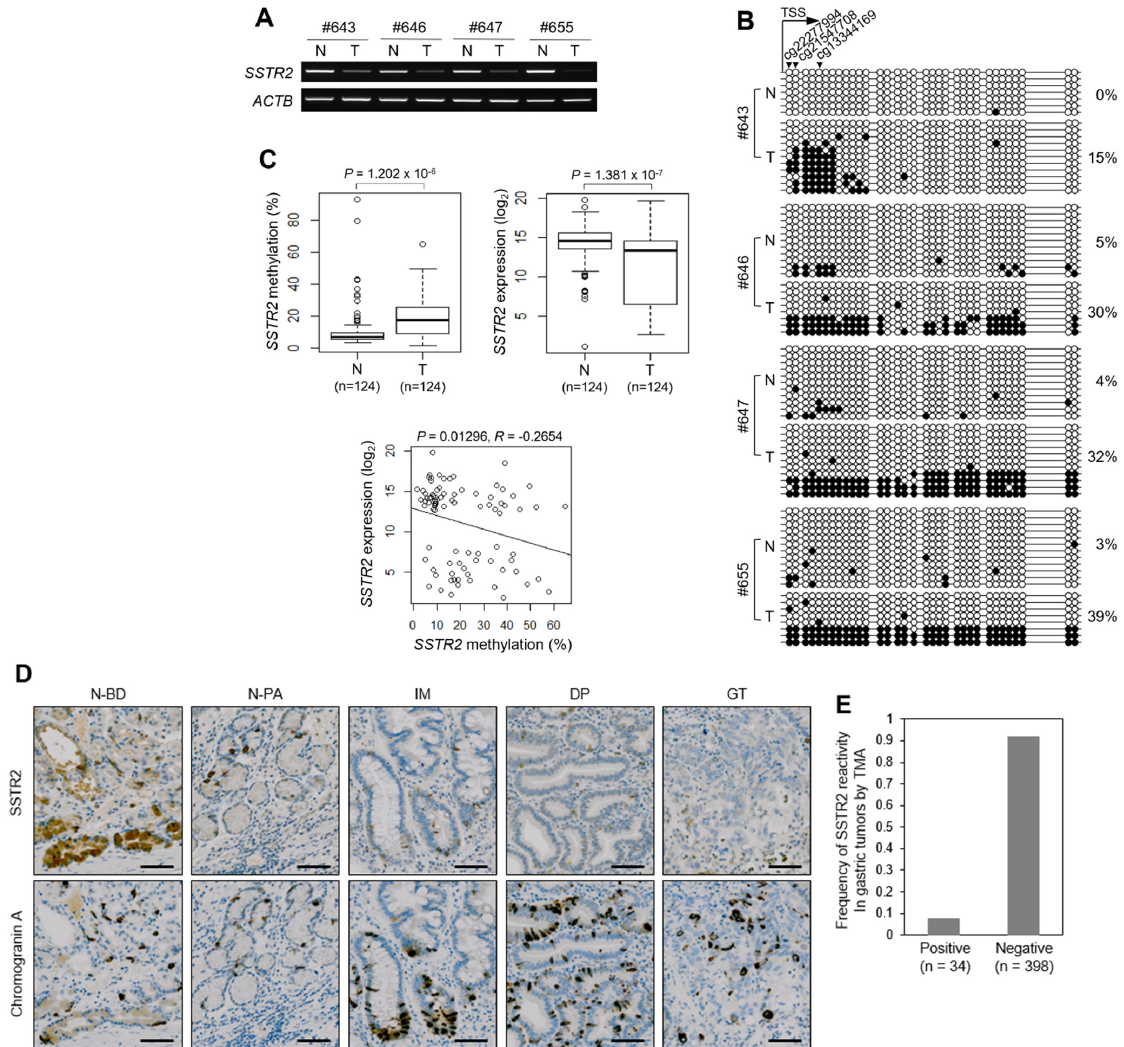
Figure 2. Promoter CpG methylation and expression for SSTR2 in primary gastric tumors. ( A ) RT-PCR analysis in clinical tissues. SSTR2 expression was examined in four paired gastric tumor tissues. ACTB was used as an internal control. ( B ) Bisulfite sequencing analysis at promoter regions. It was examined in the same clinical tissues used for RT-PCR analysis. Black and white circles indicate methylated and unmethylated CpG sites, respectively. Each row represents a single clone. Numbers on the right represent the mean percentage of CpG sites that were methylated in each sample tissue. Arrowheads in the top indicate three CpG sites, which are interested as the hypermethylated one and used for further pyrosequencing analysis. TSS, transcription start site. ( C ) Pyrosequencing (top, left), RT-qPCR (top, right) analysis, and correlation analysis between SSTR2 methylation and expression (bottom). The analysis was performed for 124 paired non-tumor and gastric tumor tissues of CNUH cohort. Pyrosequencing was performed at three CpG sites shown in Figure 2B. Box plot analyses in panels show median, 25th, and 75th percentiles and outliers. ( D ) Tissue microarray analysis (TMA) with anti-SSTR2 in clinical tissues. TMA was performed with eight arrays containing a total of 432 gastric adenocarcinomas, including internal controls such as non-neoplastic GM or IM. Upper and lower panels show representative examples for immunostaining with anti-SSTR2 and anti-chromogranin A, respectively. Chromogranin A was used as a control marker for endocrine cell. N-BD, non-neoplastic gastric body; N-PA, non-neoplastic pyloric antrum. ( E ) Frequency of SSTR2 reactivity in human gastric adenocarcinoma by TMA.